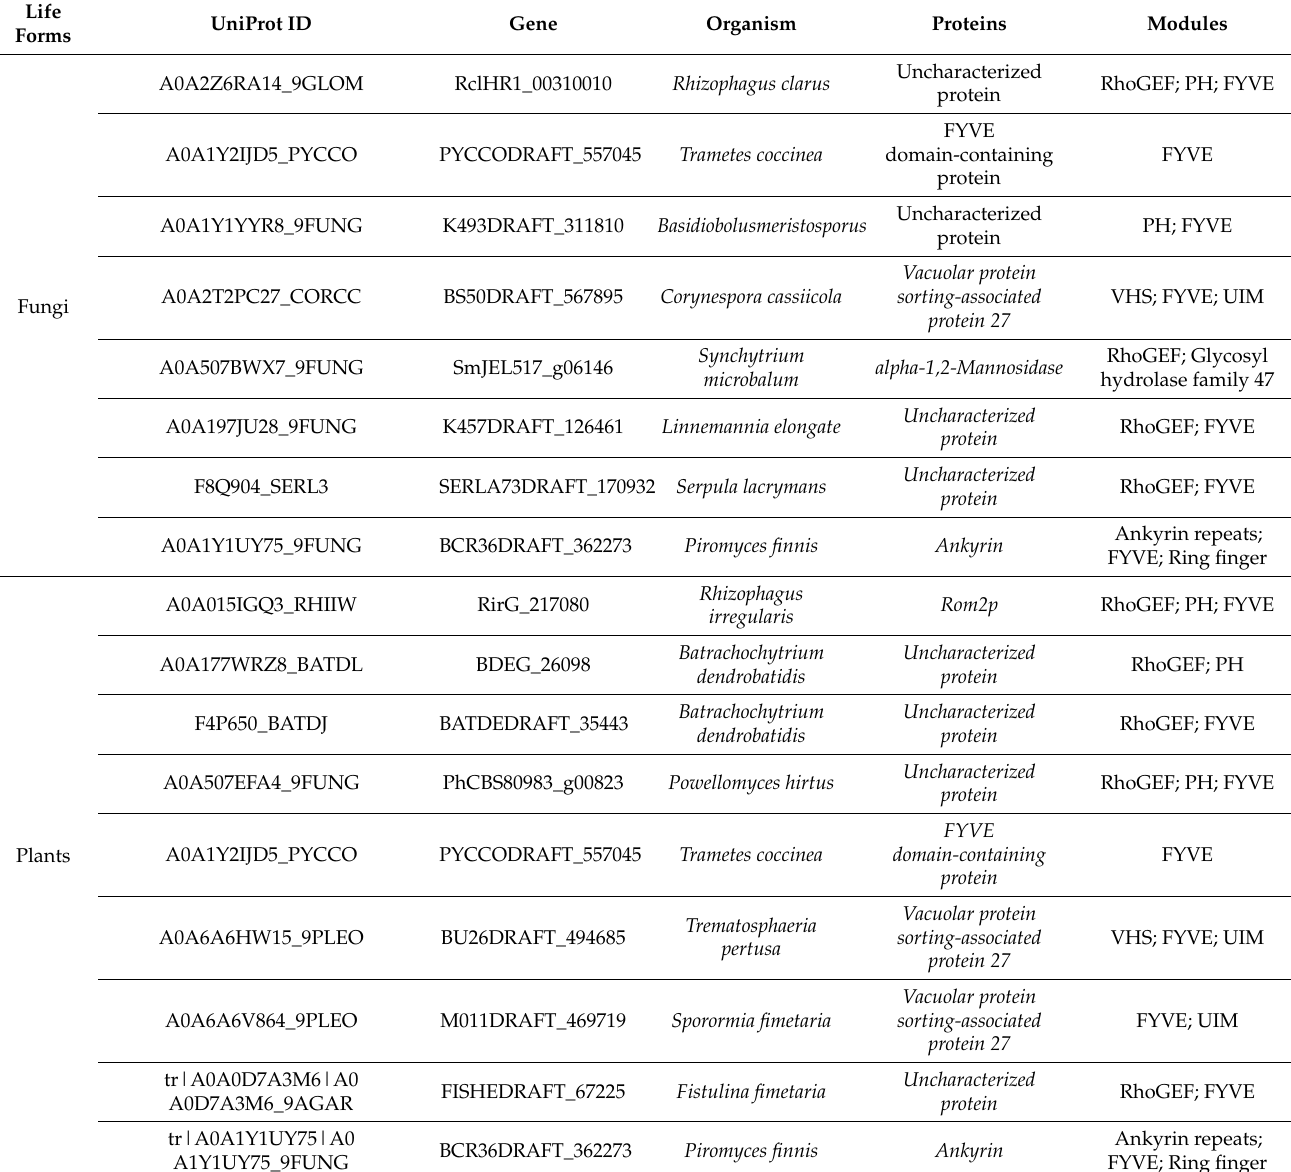
Table 1. Different modules found in fungi and plant PH- and FYVE domain-containing